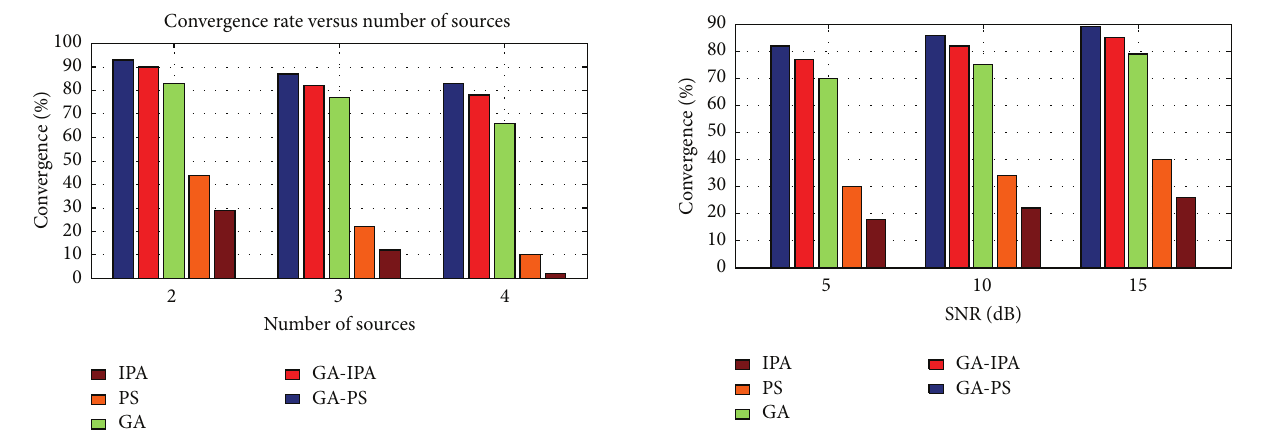
Figure 4: Convergence rate versus